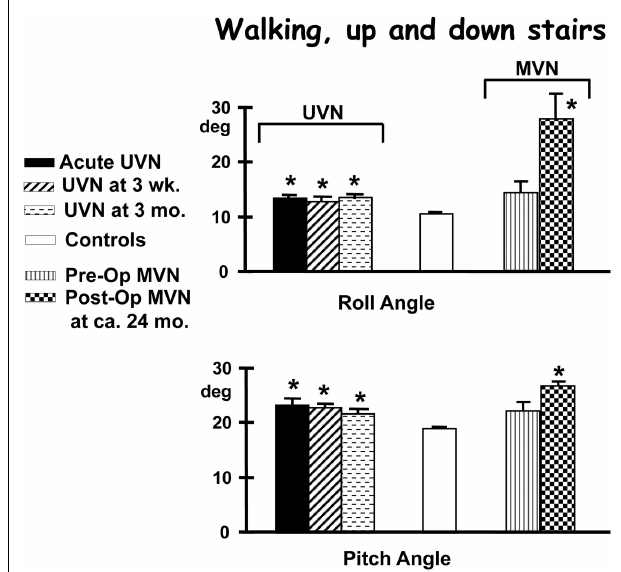
FIGURE 6 | Population means (and standard errors of the means) of peak to peak trunk angles of subjects while performing the task of walking up and down a set of stairs consisting two steps up and down. The subjects are those with an acute unilateral vestibular neuritis (UVN), healthy controls, and 14 patients pre- and post-vestibular neurectomy for intractable Ménière’s disease (MVN). For details of the figures see the legend to Figure 4 . Note that the angle deviations remain larger than controls for the 3-months of follow-up after the acute onset of UVN. Also note that MVN patients do not differ from controls pre-operatively but have larger values of trunk sway 24months post-operatively. Data from Allum and Adkin (2003),Vibert et al.